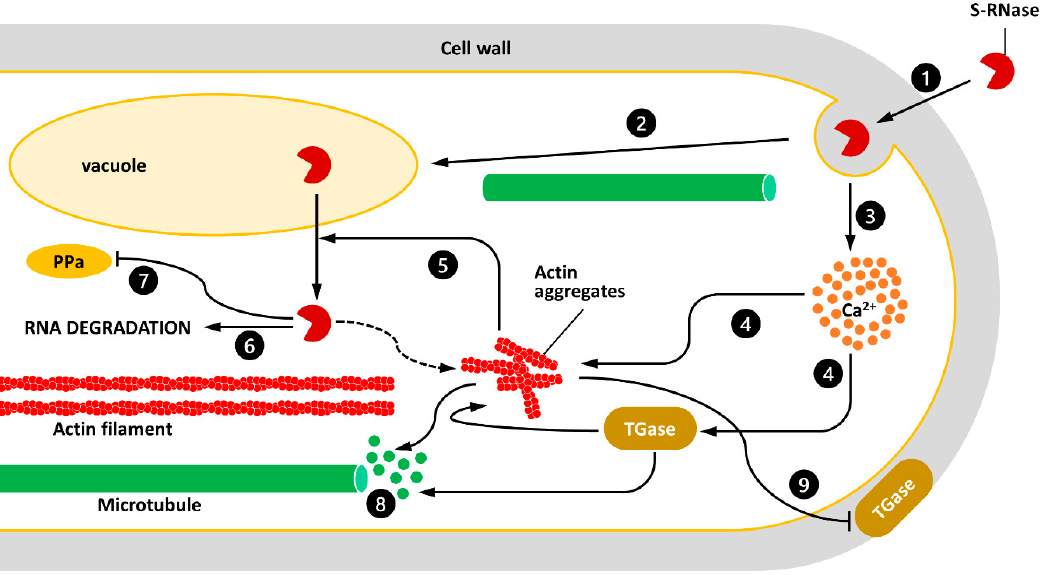
Figure 1. A speculative model illustrating the interactions between S-RNase, TGase, and the cytoskeleton of pollen tubes. (1) S-RNase is internalized through endocytotic mechanisms. (2) MTs are likely to be involved in the delivery of S-RNase to the vacuole. (3) Intake of the S-RNase results in an increase in the cytosolic concentration of calcium ions. (4) Increasing the Ca 2+ concentration can affect the stability of AFs and unbalance the activity of TGase. (5) The alteration of AFs promotes the release of S-RNase from the vacuole. (6) S-RNase may degrade the RNA of pollen tubes; (7) alternatively, S-RNase may inactivate specific enzymes such pyrophosphatases (PPa). (8) The depolymerization of AFs or the formation of actin aggregates might in turn destabilize MTs and related processes. (9) Damage to the cytoskeleton affects the secretion of the extracellular TGase, which in turn affects pollen tube growth.